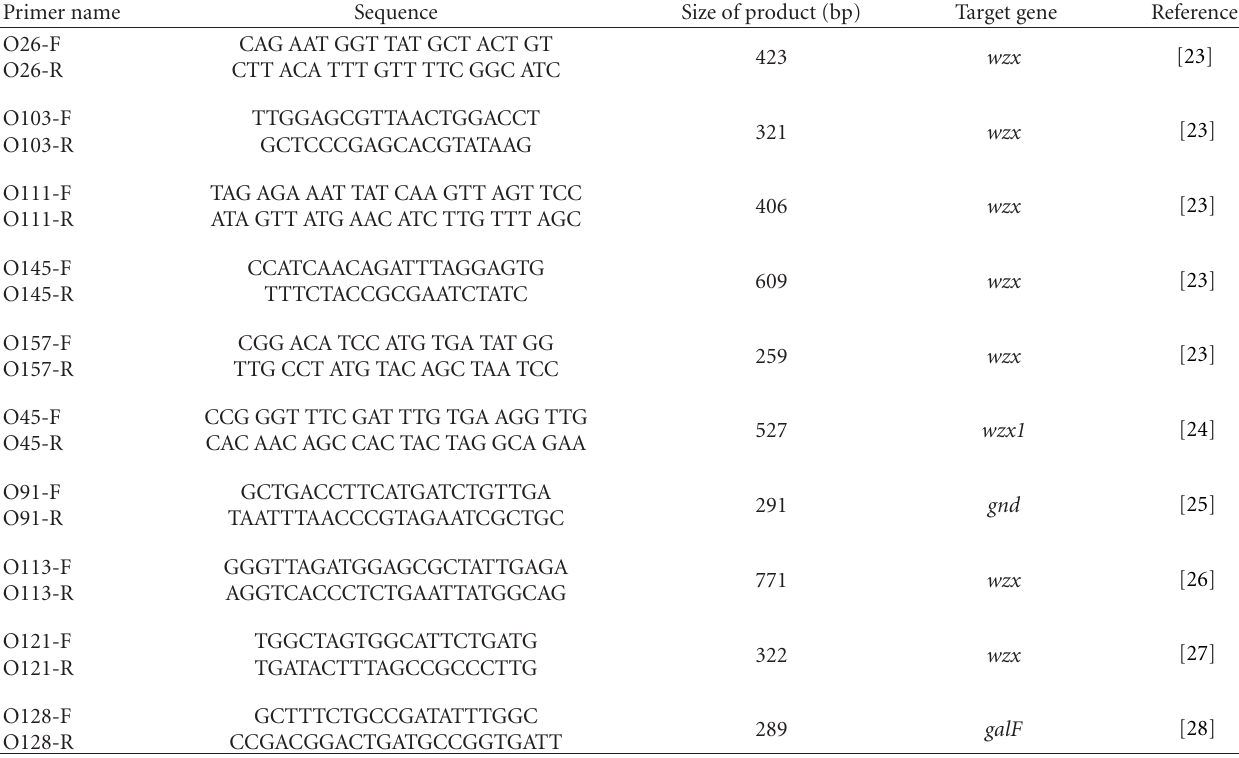
Table 2: Primers used for detection of Shiga toxin-producing Escherichia coli serogroups isolated from bovine